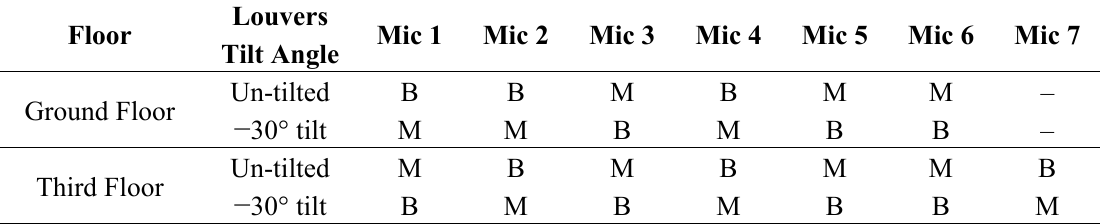
Table 2. Table of the mutual position between microphones and